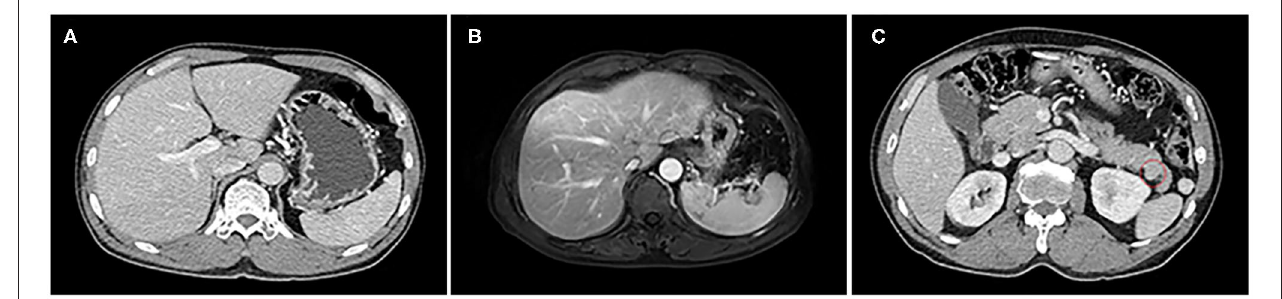
FIGURE 1 | The liver with standard size and shape on CT and MRI; there are no symptoms of liver cirrhosis that can be observed. (A) Abdominal CT scan. (B) MRI scan. A tiny oval and smooth tumor was shown in the enhanced CT scan (C)